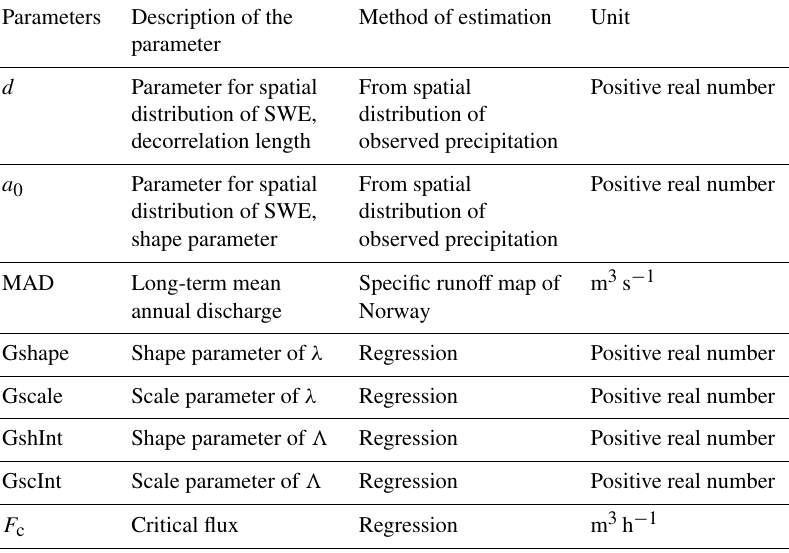
Table A1. List of DDD model parameters estimated from observed precipitation data and those estimated from regionalization (multiple regression) for the study catchments.